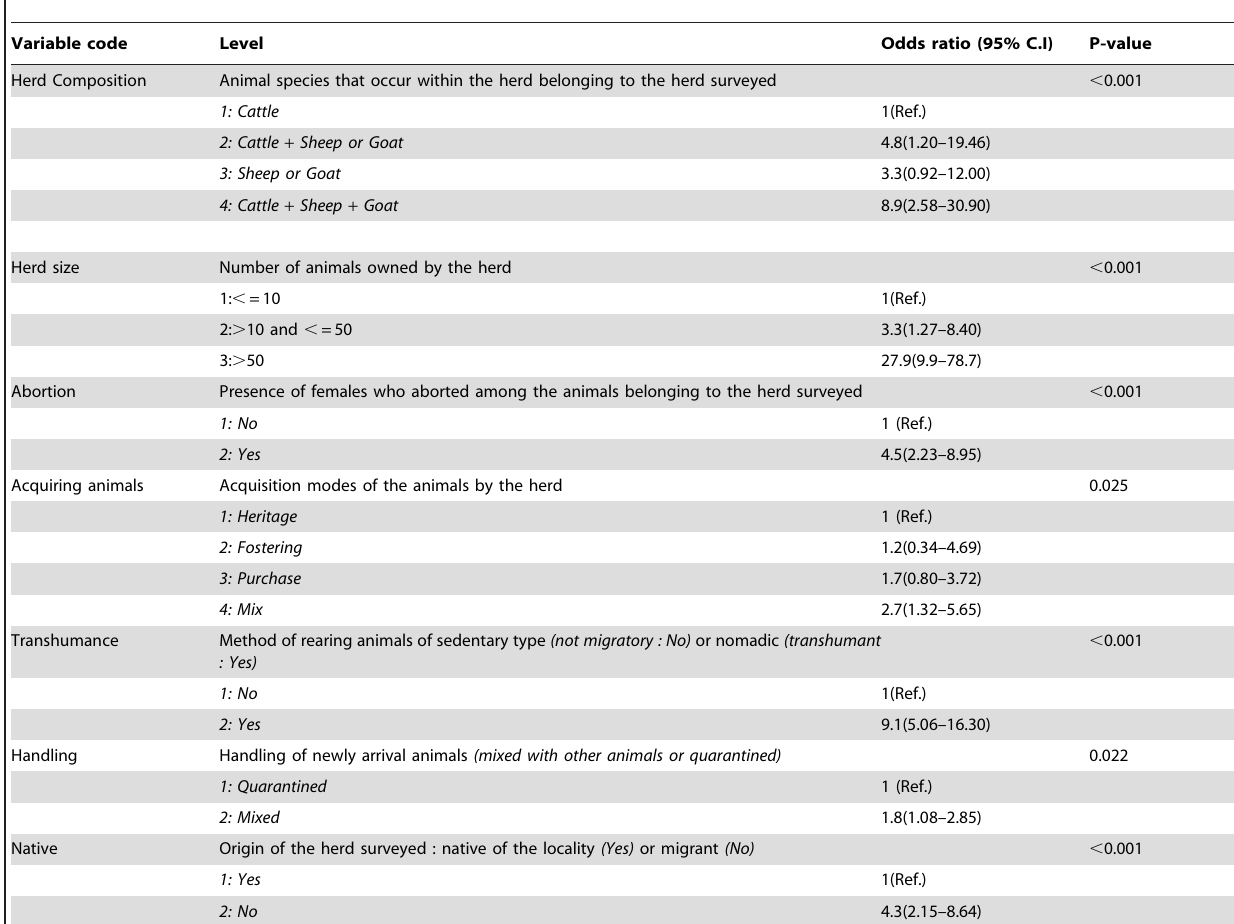
Table 5. Potential risk factors associated with herd level seroprevalence of brucellosis based on a univariate random effects model with strata forced in as a fixed effect and site as a random